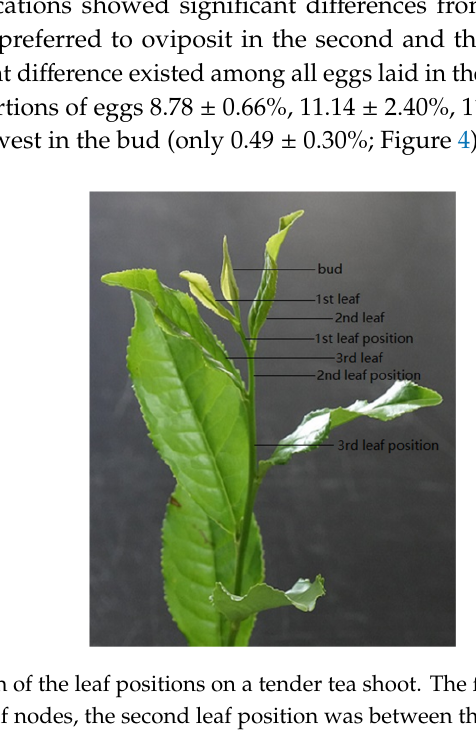
Figure 4. Egg distribution of E. onukii at different leaf positions on the tea shoots. The values (mean ± SE) with different letters in different leaf positions indicate a significant difference at the p < 0.05 level by LSD test. 3.7. Egg Laying by Single Females Daily and the Whole Generation Our study demonstrated that for seven consecutive days, the average numbers of eggs laid daily by a single female of E. onukii were 3.10, 3.33, 2.67, and 2.51, respectively (Table 6). Furthermore, during the lifespan of an E. onukii adult female, the ovipositional duration was about 20 days, with the highest fertility of up to 42.8 eggs (Table 7).